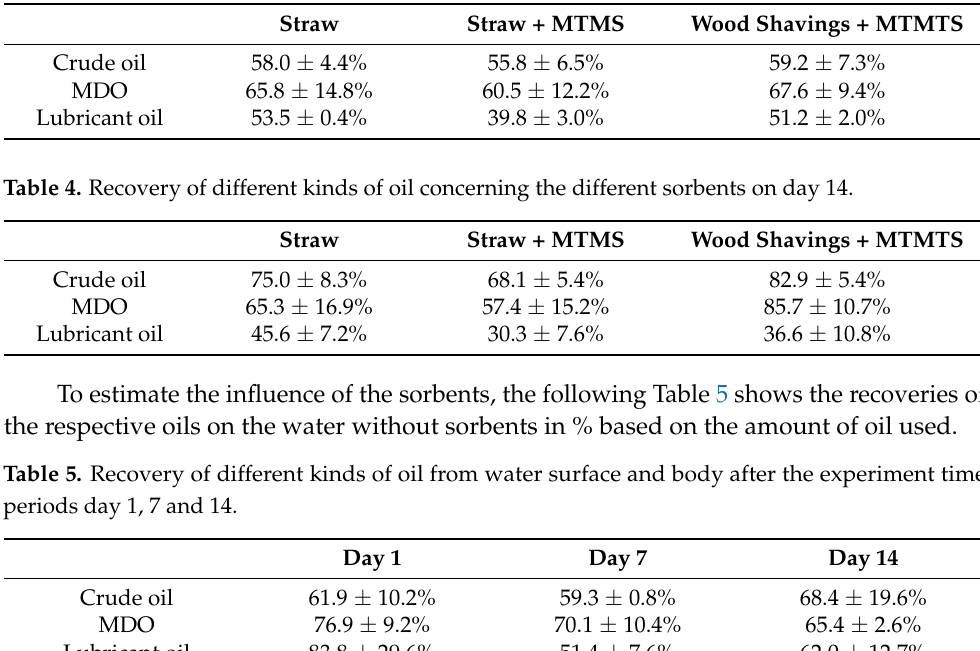
Table 3. Recovery of different kinds of oil concerning the different sorbents on day 7.